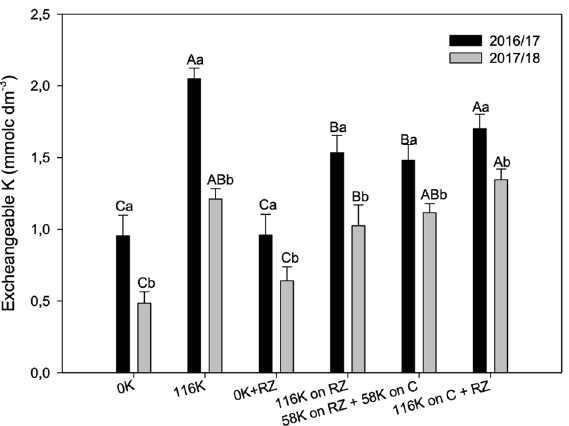
Figure 1. Exchangeable soil K in a 0–20 cm depth under potassium fertilization management after cotton harvest for two seasons. A > B for K management within each growing season and a > b for growing season within K